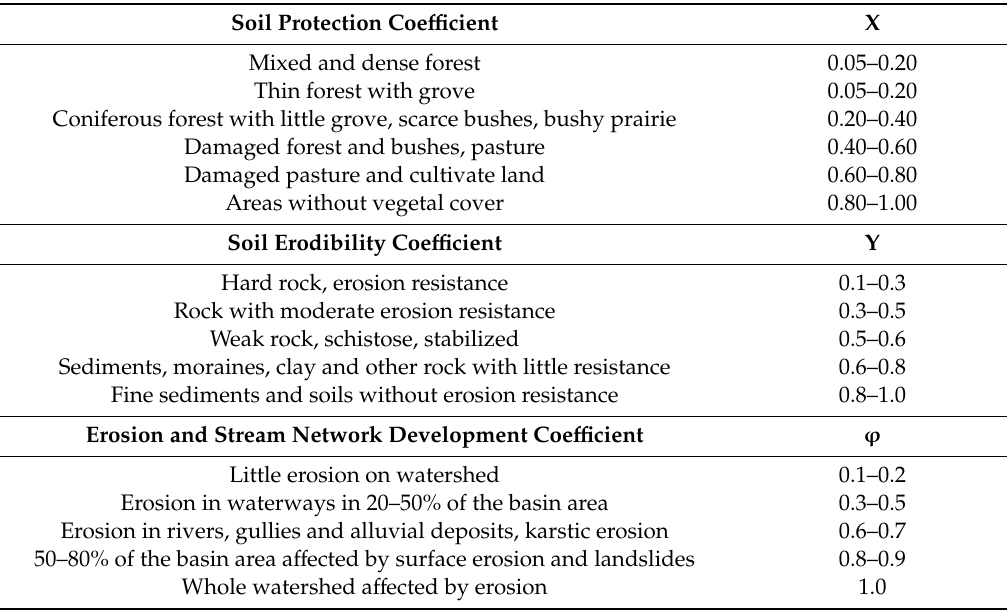
Table 1. Coe ffi cient values of the EPM